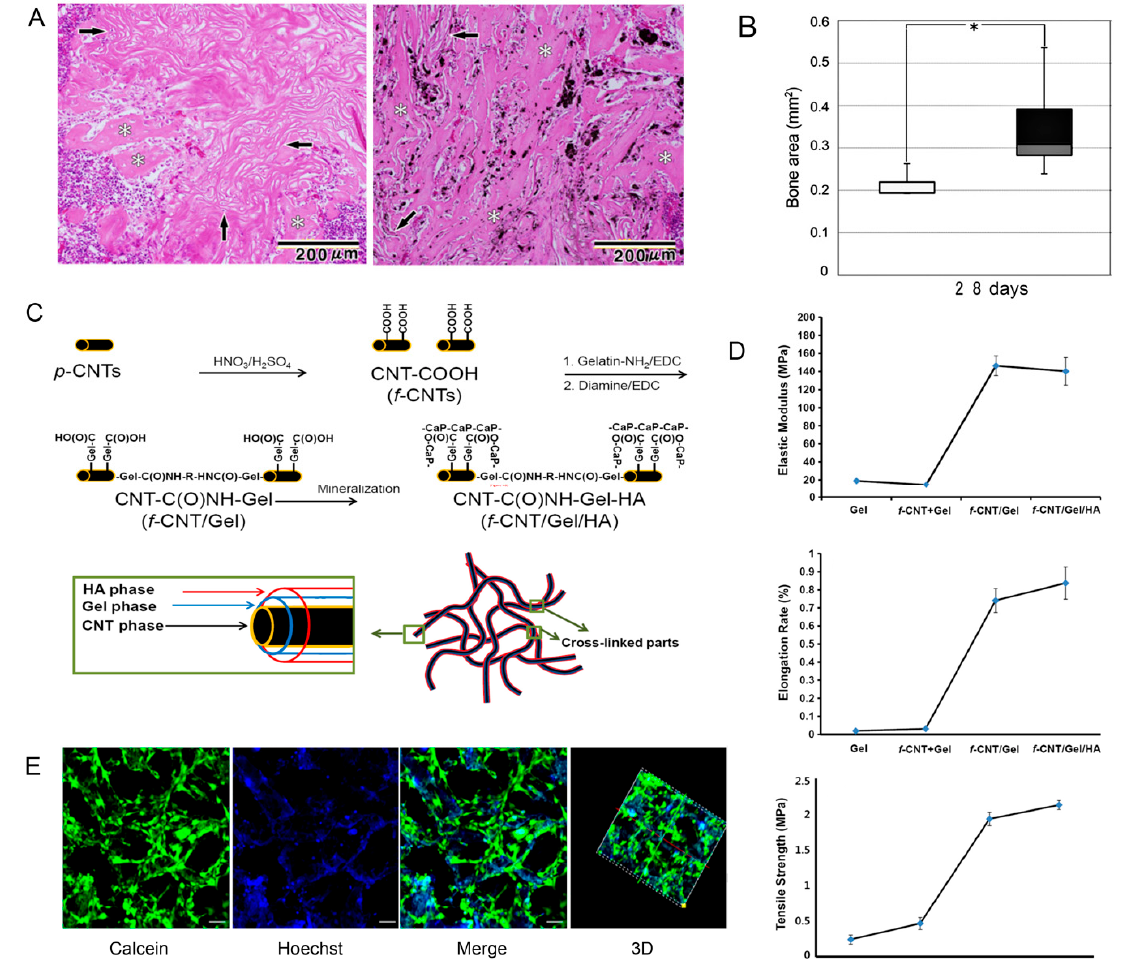
Figure 4. Carbon nanotube (CNT)-based collagen and gelatin natural polymer matrix for bone formation. ( A ) Histology of bone formation (white asterisk) at 28 days after bone marrow implantation. The uncoated sponge on the left is surrounded by a small amount of newly formed bone; the MWCNT-coated sponge on the right is surrounded by a large amount of newly formed bone. ( B ) The amounts of new bone formed around the MWCNT-coated sca ff old are significantly higher than that around uncoated sca ff olds at 28 after implantation (* p < 0.05). ( C ) Schematic demonstration of